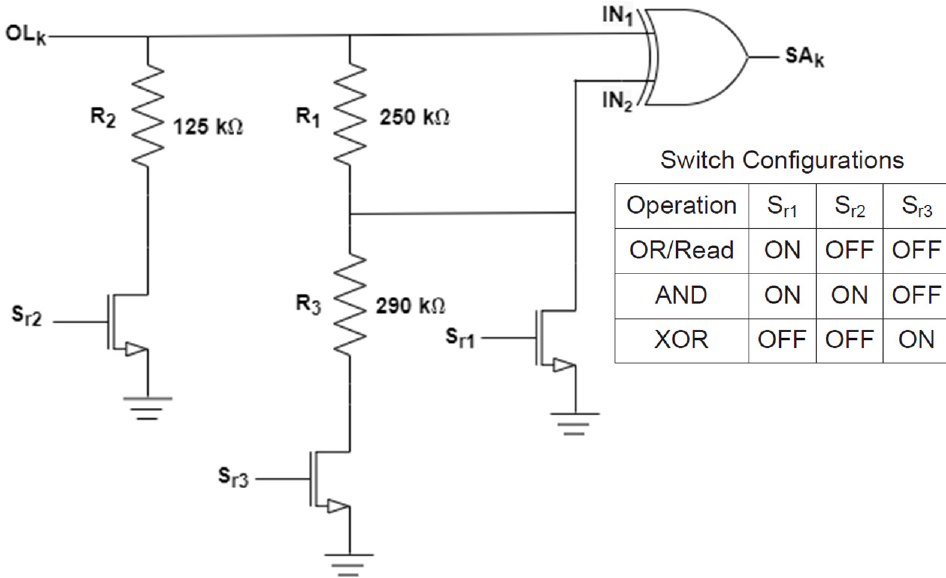
Figure 3. Circuit schematic of voltage-based sense amplifier for scouting logic (adapted from Reference [17]). Inset shows the different possible configurations to activate different voltage reference values at IN 1,2 terminals. Resistor values were selected based on simulation results, assuming 2-input AND/OR/XOR logic operations, and memristors with HRS/LRS = 125 G Ω /125 K Ω .